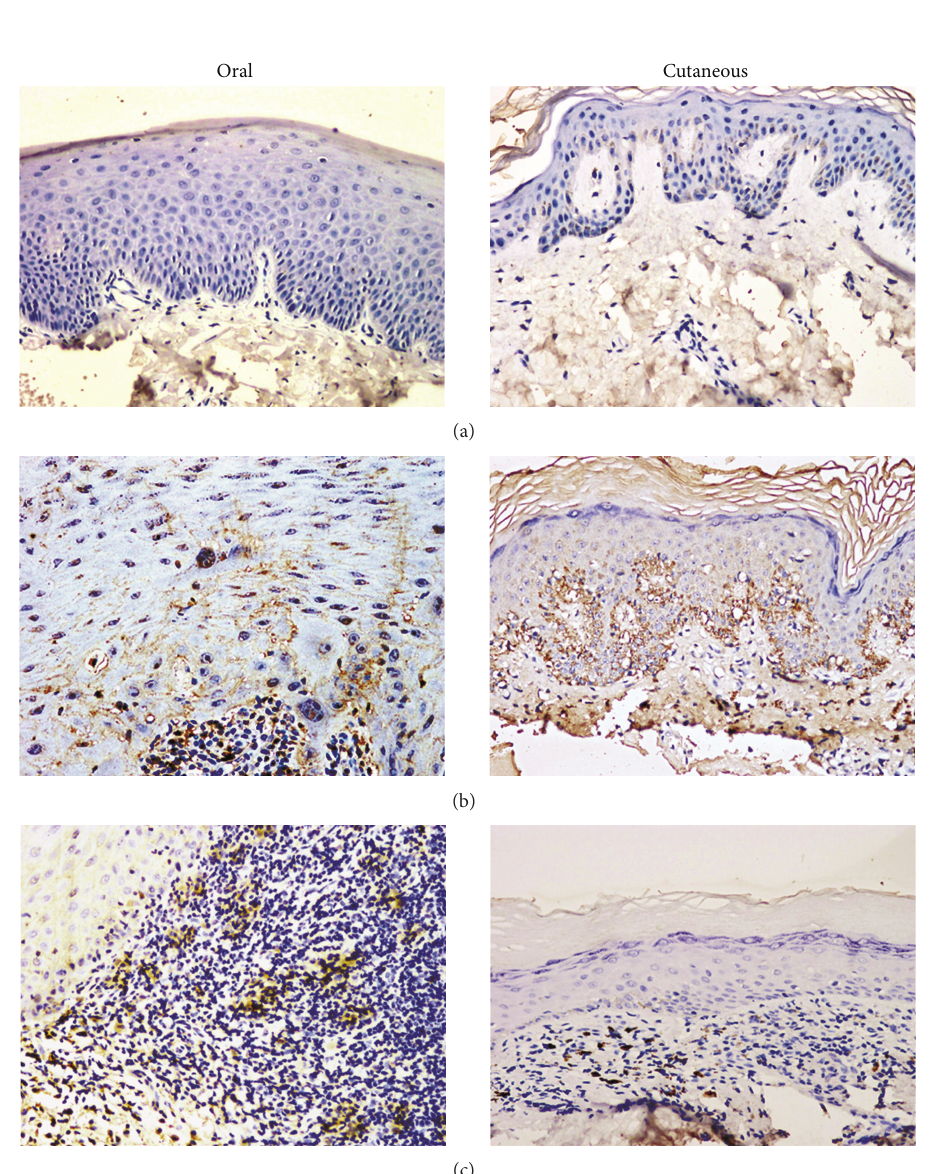
Figure 1: Representative expression pattern of IL-22: (a) negativity in normal oral mucosa and normal skin; (b) positivity in epithelial cells of oral and cutaneous lichen planus (LP); (c) positivity in subepithelial cells of oral and cutaneous LP. Magnification, × 200.